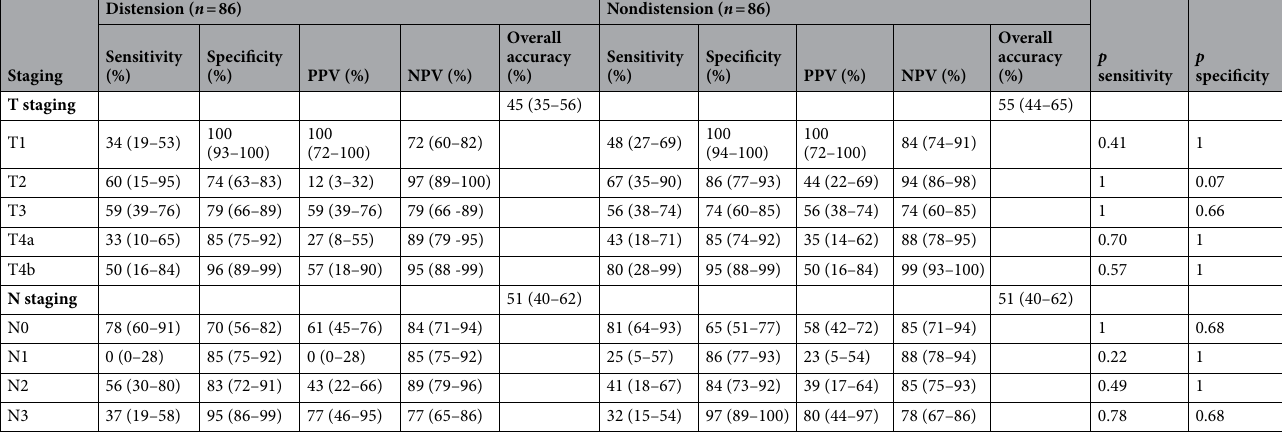
Table 3. Diagnostic performance of individual TN staging. Data presented as percentages and 95% confidence interval in parenthesis. NPV negative predictive value, PPV positive predictive